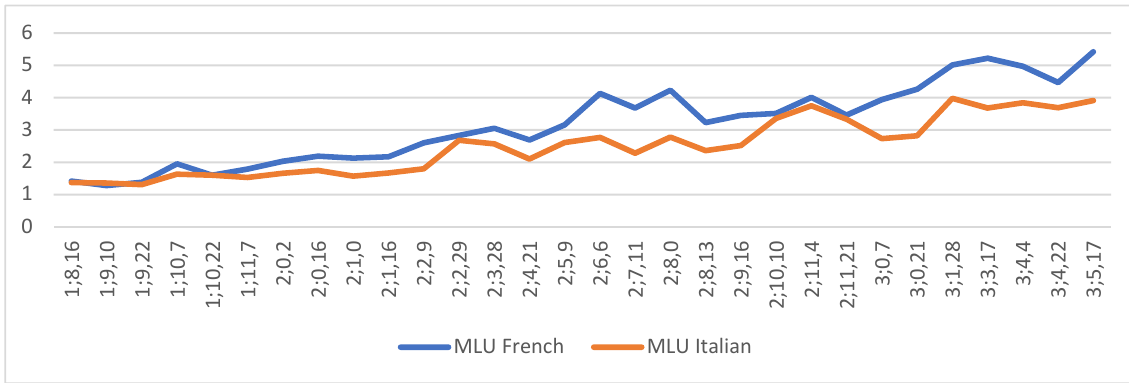
Figure 1. Ju_fi’s MLU development in French and Italian.